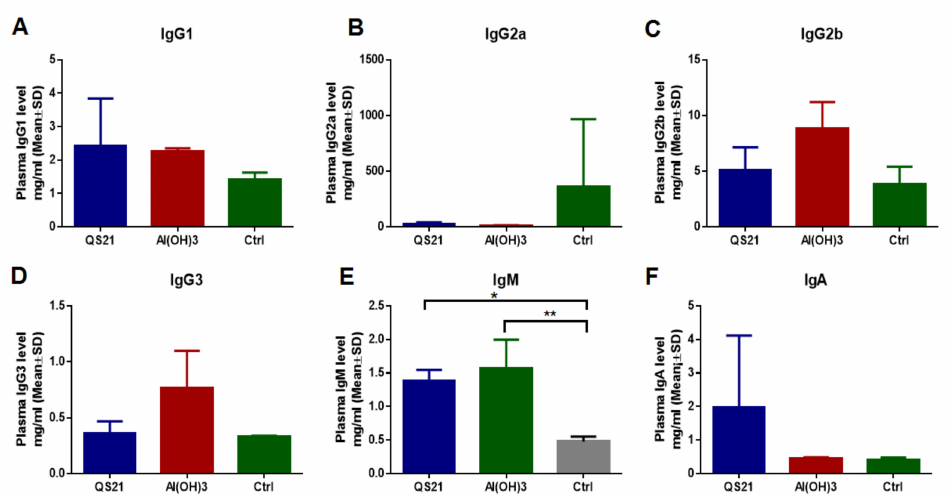
Figure 7. Ig Isotyping results of plasma from mice vaccinated with peptide mixture group 1. ( A ) IgG1 level; ( B ) IgG2a level; ( C ) IgG2b Level; ( D ) IgG3 Level; ( E ) IgM Level; ( F ) IgA Level; (the final dilution of mice plasma was at 1:10,000) (* p < 0.05, ** p < 0.01, N = 3 per